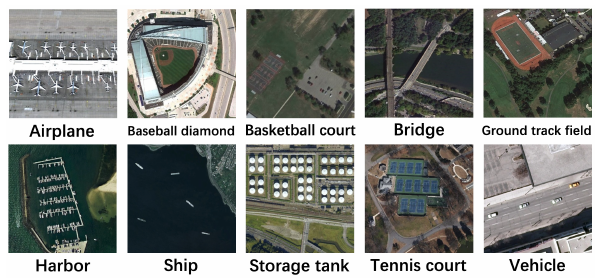
Figure 9. A set of sample images for each class in NWPU VHR-10.